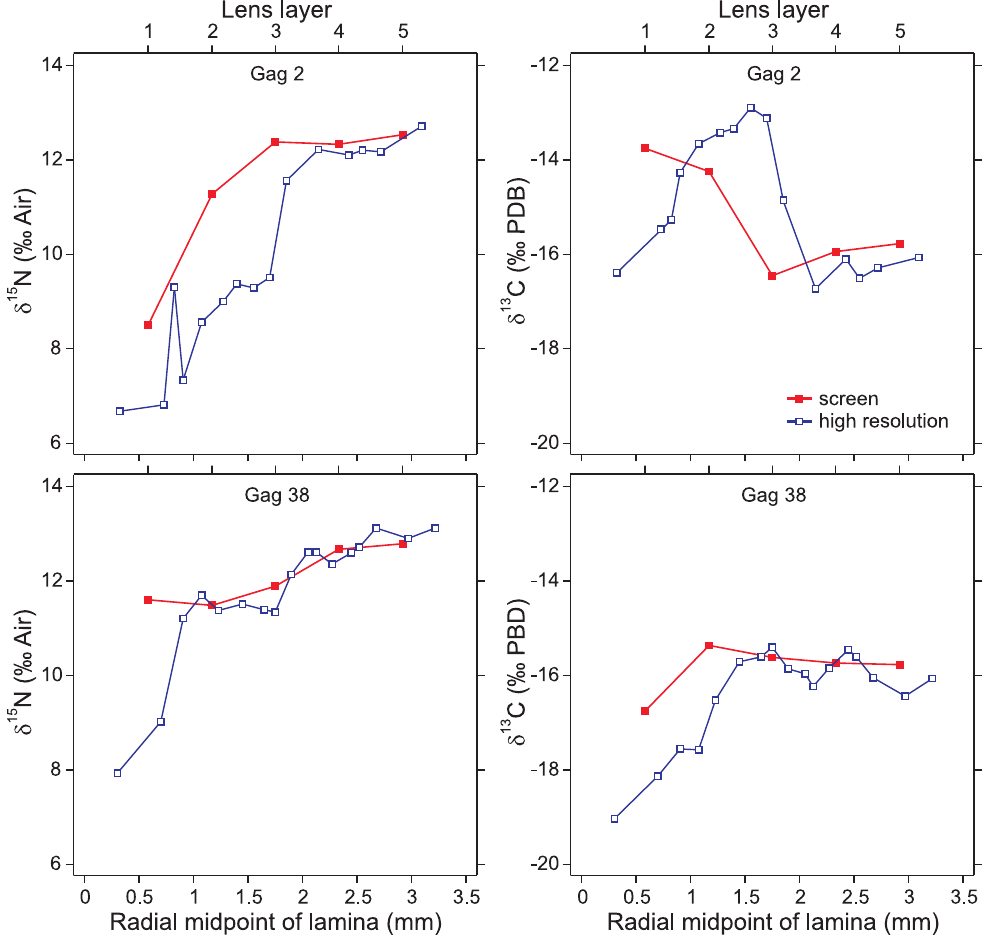
Figure 2. Low- and high-resolution comparison. The low-resolution screening method (analysis of coarse lens layers) is compared with the high-resolution method (analysis of individual laminae) for gag 2 (upper panels) and gag 38 (lower panels). The leftmost observation in the high- resolution method is for the lens nucleus; the remaining observations are for individual laminae. Gag 2 was 704 mm total length (TL); gag 38 was 832 mm TL. Both were